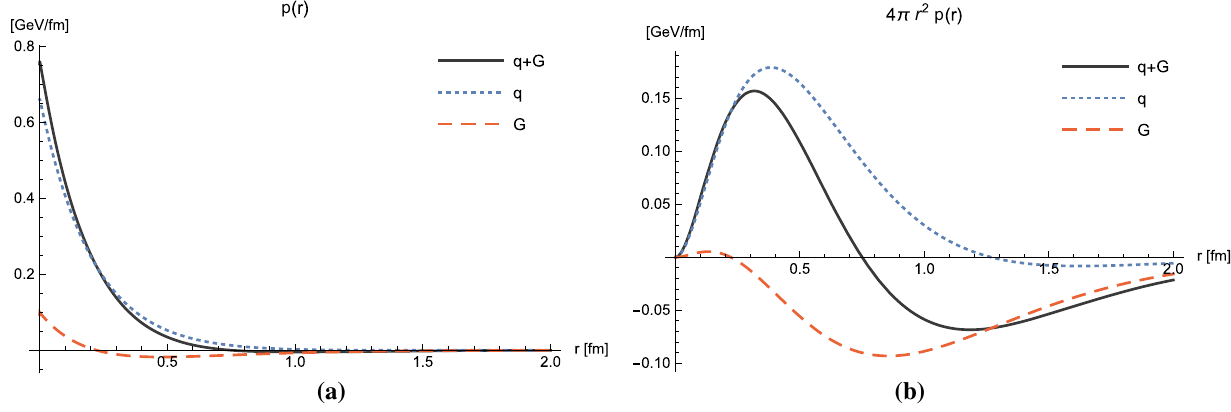
Fig. 6 Plots of the isotropic pressure, a p ( r ) and b 4 π r 2 p ( r ) , using the multipole model (11) with parameters given in Table 1, see Eq. (37) or Eq. (42) for definitions in terms of GFFs